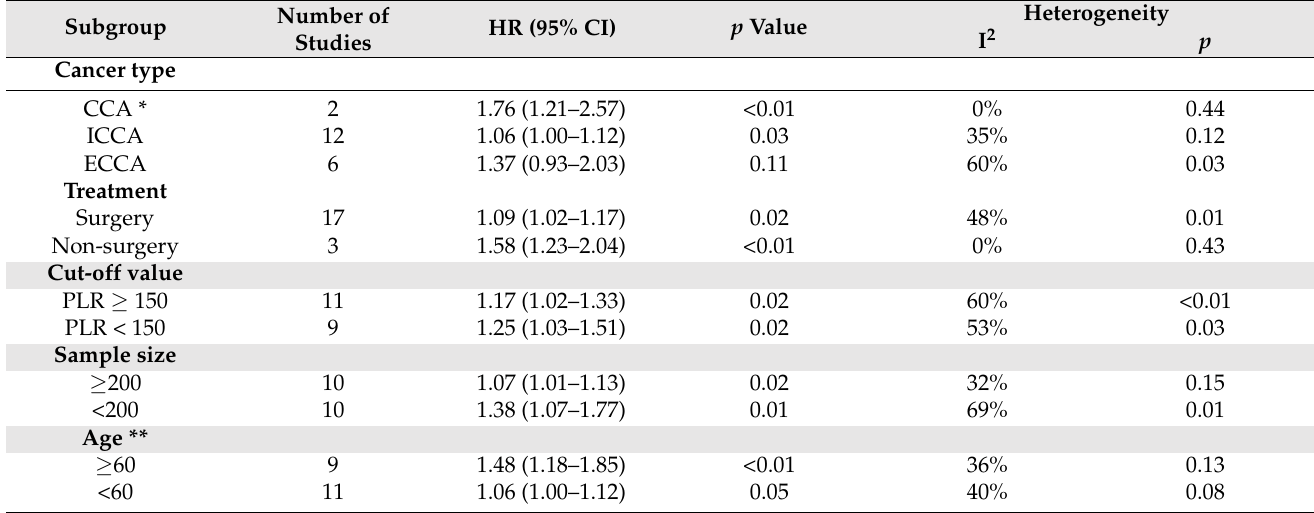
Table 3. Summary of the subgroup analyses of the correlation between the PLR and OS in CCA patients. * Includes both ICCA and ECCA. ** Mean/median age of the study cohort. ECCA, extrahep- atic cholangiocarcinoma; ICCA, intrahepatic cholangiocarcinoma; NLR, neutrophil-to-lymphocyte ratio; PLR, platelet-to-lymphocyte